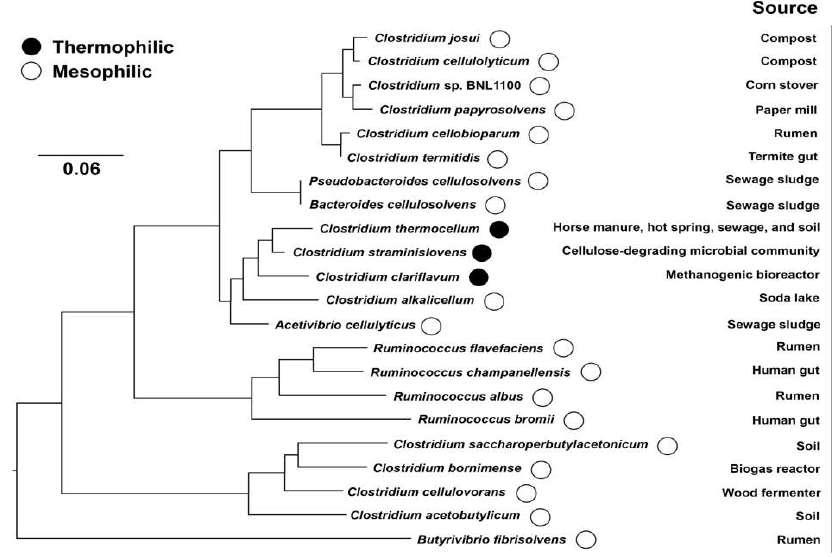
Figure 1. Figure 1. Phylogenetic tree based on 16S rRNA sequencing of the anaerobic cellulosome-producing bacteria.